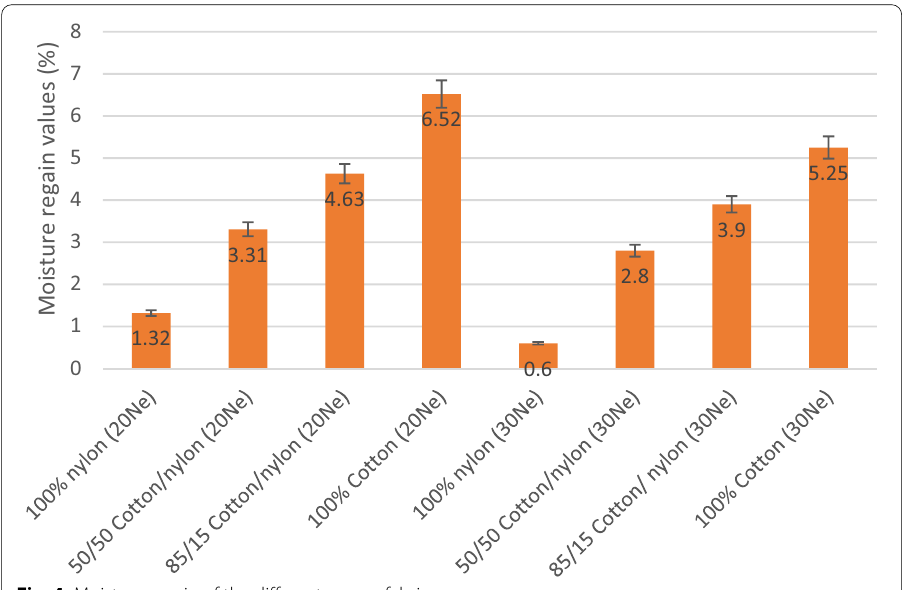
Fig. 4 Moisture regain of the different woven